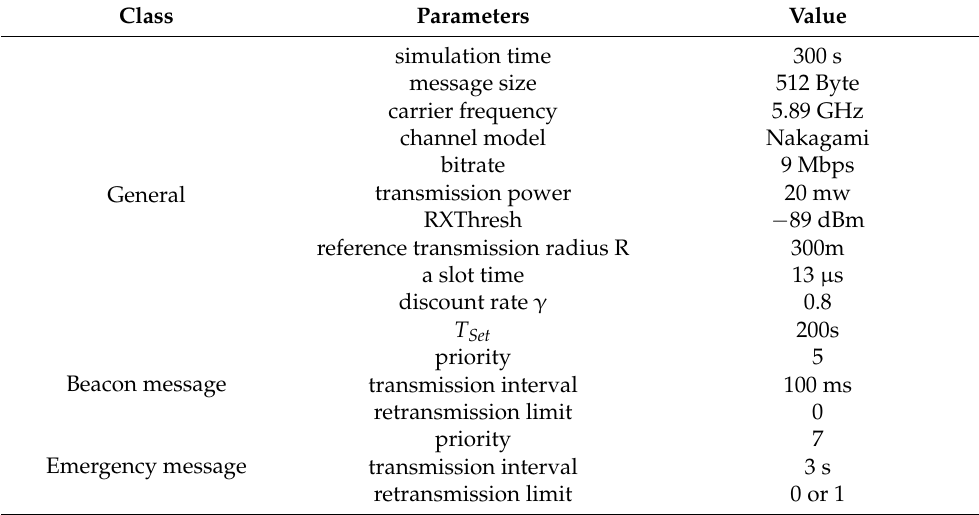
Table 4. Simulation